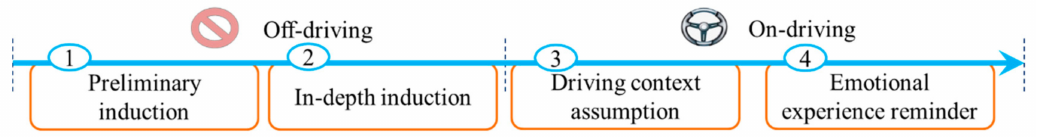
Figure 9. Emotion induction